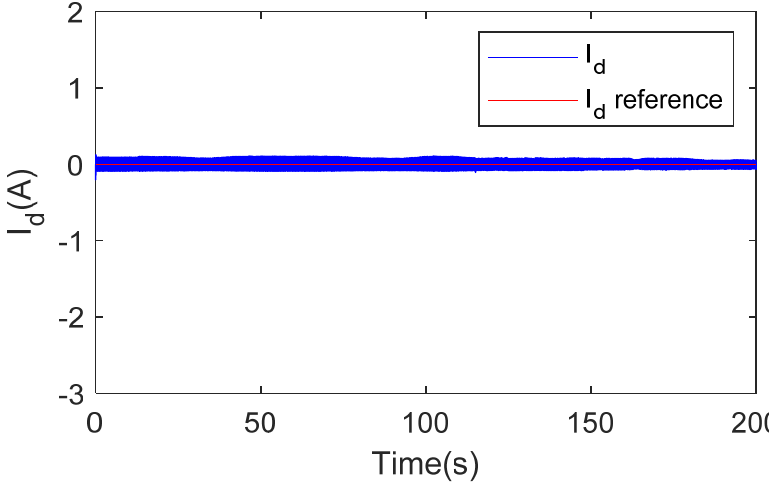
Figure 8. i d current control result.